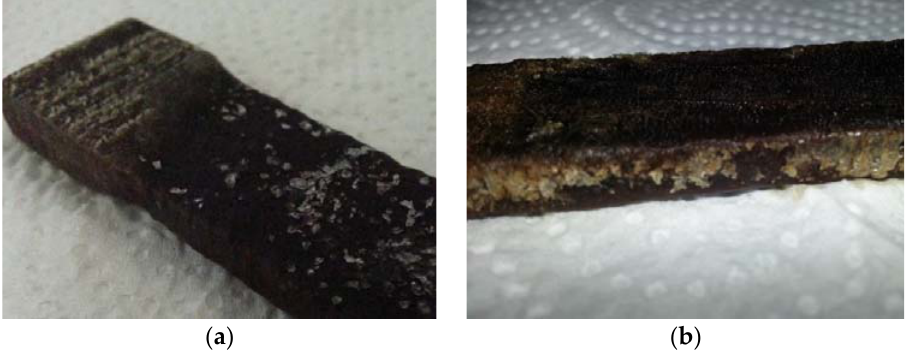
Figure 3. Dry samples of beech ( a ) and oak ( b ) after three weeks